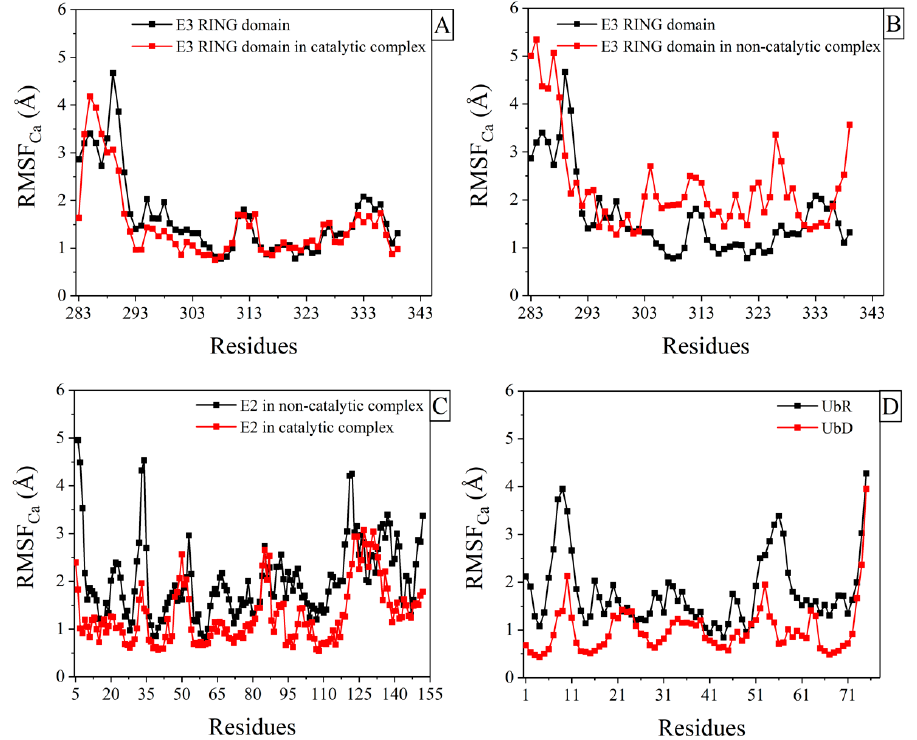
Figure 2. ( A ) Structural fluctuations (RMSF of Ca atoms per residue) for the core of RING domain of the human Ark2C E3 ligase simulations (black) and in the complex with E2-Ub in the catalytic conformation (Ub–RING-E2-Ub, red); ( B ) Structural fluctuations (RMSF of Ca atoms per residue) for the core of RING domain of the human Ark2C E3 ligase simulations (black) and in the complex with E2-Ub in the non-catalytic conformation (RING-E2-Ub, red); ( C ) Structural fluctuations (RMSF of Ca atoms per residue) for the E2 enzyme in the non-catalytic conformation of the E3-E2-Ub D complex (black) and in the catalytic conformation of the Ub R -E3-E2-Ub D complex (red); ( D ) Structural fluctuations (RMSF of Ca atoms per residue) for the Ub R bound to RING domain (black), and Ub D bound to E2 (red) in the catalytic conformation of the Ub R -E3-E2-Ub D complex.